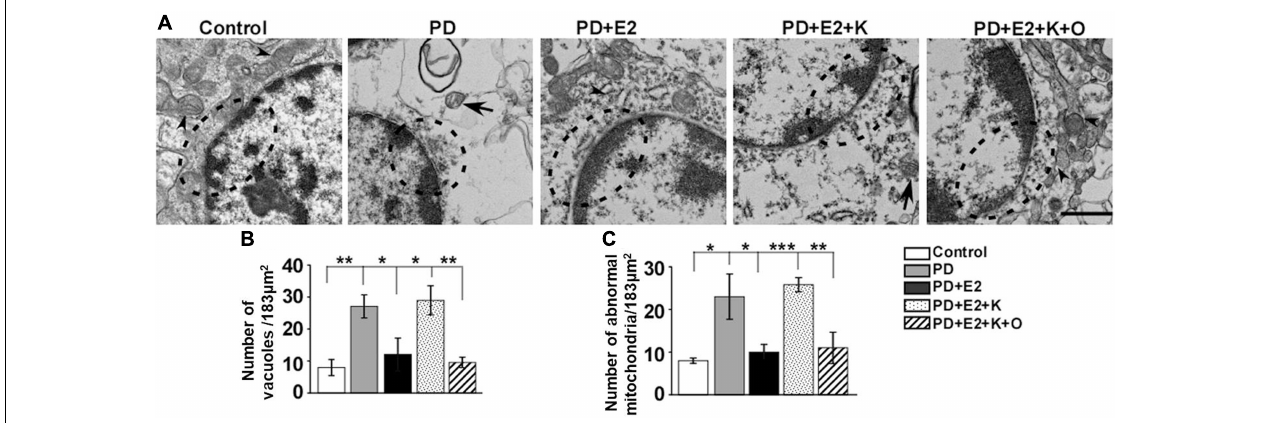
FIGURE 7 | Transmission electron microscopy of hippocampus in the different groups. (A) Neurons in the control group were normal, while neurons in the PD group seemed degenerated with discontinuous nucleus membrane; a large number of vacuoles appeared in the cytoplasm; the destroyed neurons were also seen in the PD + E 2 + K group. The morphology of neurons in the control group was similar to that of the PD + E 2 and PD + E 2 + K + O groups. The dotted boxes indicated the morphological changes of the nuclear membrane; arrowheads indicated normal mitochondria; arrows with lines indicated abnormal mitochondria. Scale bar = 1 µ m. Histograms showing the changes in number of vacuoles (B) and abnormal mitochondria (C) in the control group, PD group, PD + E 2 group, PD + E 2 + K group, and PD + E 2 + K + O group ( n = 3, each group). Results are presented as mean ± SEM. * p < 0.05; ** p < 0.01; *** p < 0.001.